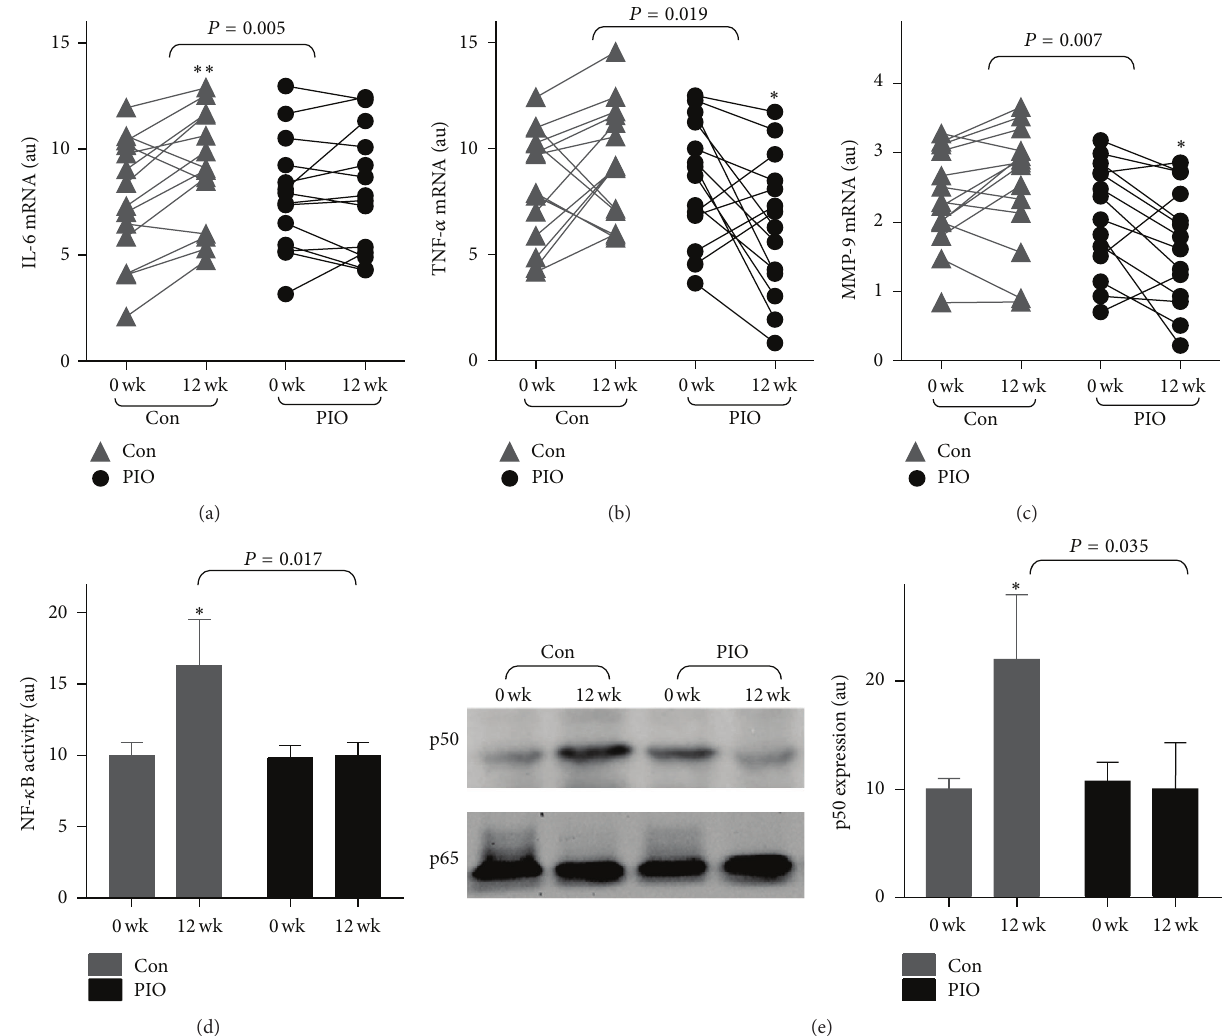
Figure 2: Pioglitazone downregulated the proinflammation in MNC. (a)–(c) Change in mRNA expression of peripheral blood mononuclear cells (MNC). The mRNA levels of IL-6, TNF- 𝛼 , and MMP-9 were detected by quantitative real-time PCR. (d) NF- 𝜅 B DNA binding activity was detected. (e) The expression of p50 subunit and p65 subunit in MNC. ∗ 𝑃 < 0.05 and ∗∗ 𝑃 < 0.01 compared with baseline.